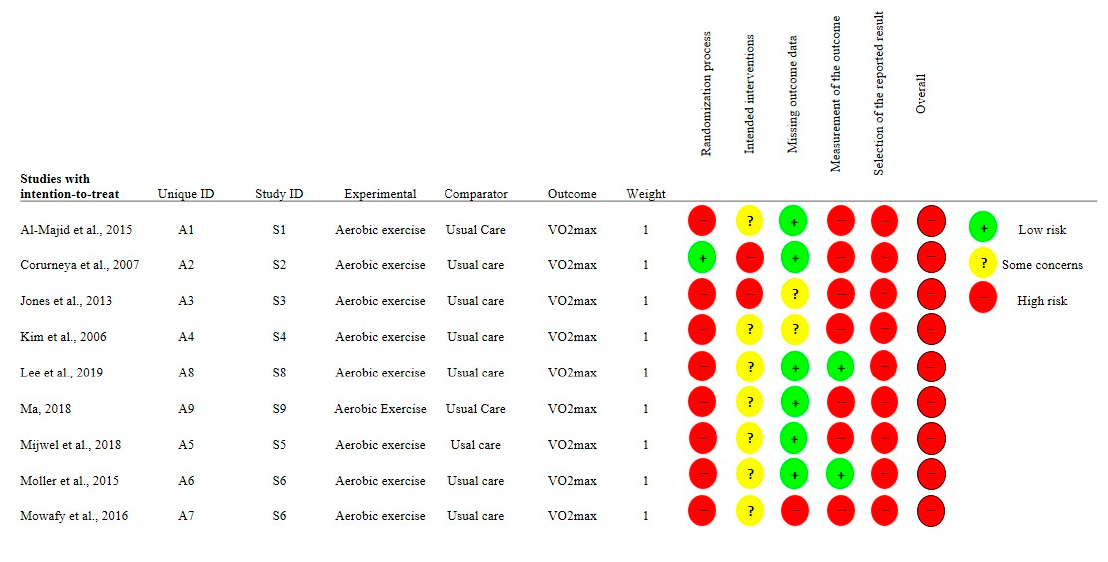
Figure 1. Risk of bias assessment for the studies included in the meta-analysis. Footnotes: AE = Aerobic Training; UC = Usual Care.